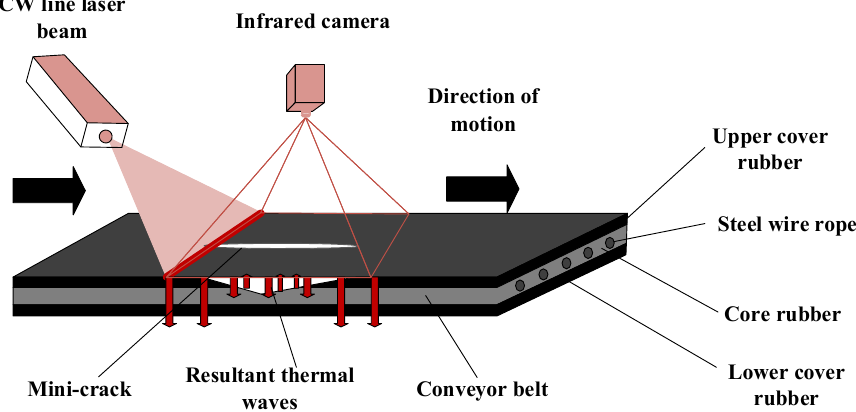
Figure 1. Working principle of laser excited thermography for conveyor belt mini-crack detection.